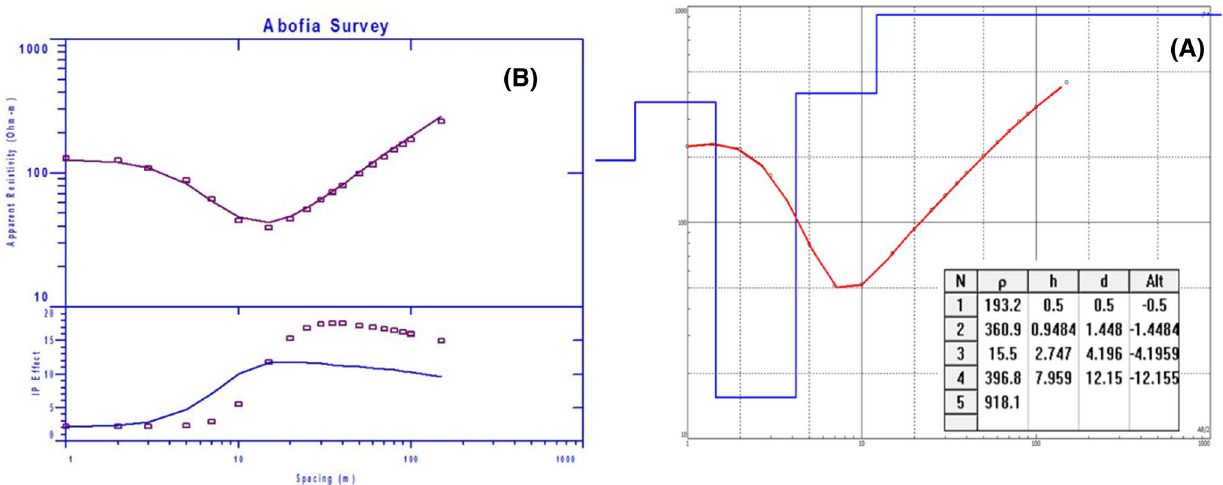
Fig. 4 a Geoelectric units for VES 2 (Abofia area) with the apparent resistivity curve, b VES-IP curves distinguishing geoelectric layers repre- sentative lithologies